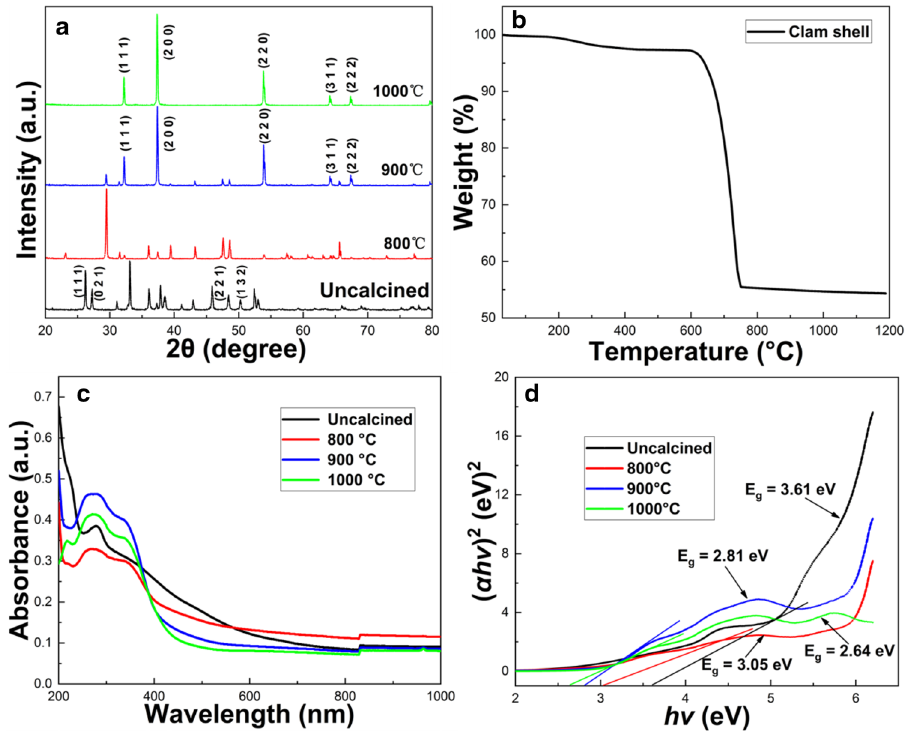
Figure 2. ( a ) XRD spectra of uncalcined, treated at 800, 900, and 1000 °C clam shell samples. ( b ) Thermogravimetric analysis of clam shell during calcination process. ( c ) Absorption spectrum and ( d ) optical band gap of different clam shell